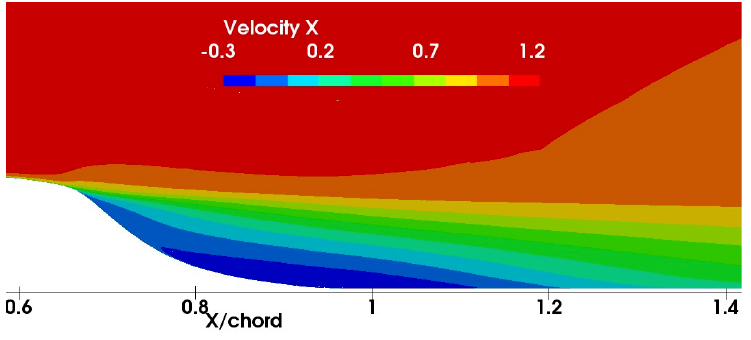
Figure 4. WA-URANS of NASA hump flow: contours of mean streamwise velocity, normalized by bulk flow reference velocity, around the separation bubble.